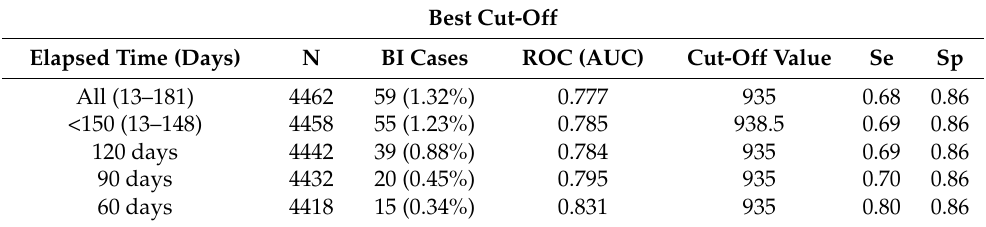
Figure 1. Cumulative incidence of previous BI as a function of anti-S IgG titer coded in deciles. Different curves were computed using different time windows for previous BI occurrences. Table 1. Discriminant power of antibody-S IgG titer to SARS-CoV-2 in predicting breakthrough infection, evaluated by area under the ROC curve (ROC-AUC). Discriminant power was computed for different time intervals preceding antibody assessment.